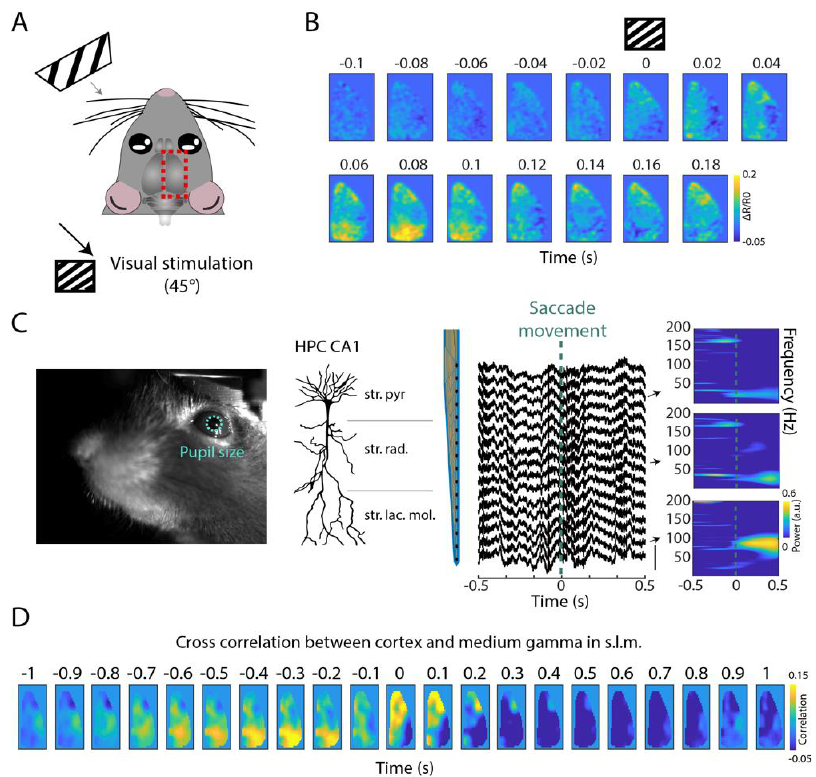
Figure 3. Visual information propagates to cortical association areas and the hippocampus. ( A ) Schematic of the visual stimuli paradigm. ( B ) Average cortical voltage activity profile during specific visual stimulation pattern (45 ◦ ) (N = 50 trials). ( C ) Facial camera with pupil size detected using DeepLabCut ( left panel). Average local field potential of the hippocampal silicon probe around the saccade movement of the eyes ( right panel). The spectrogram shows the spectral average of three channels (each located in stratum pyramidale, stratum radiatum and stratum lacunosum moleculare) around the saccade movement of the eye. ( D ) Cross correlation between each cortical pixel and medium gamma power in the stratum lacunosum moleculate